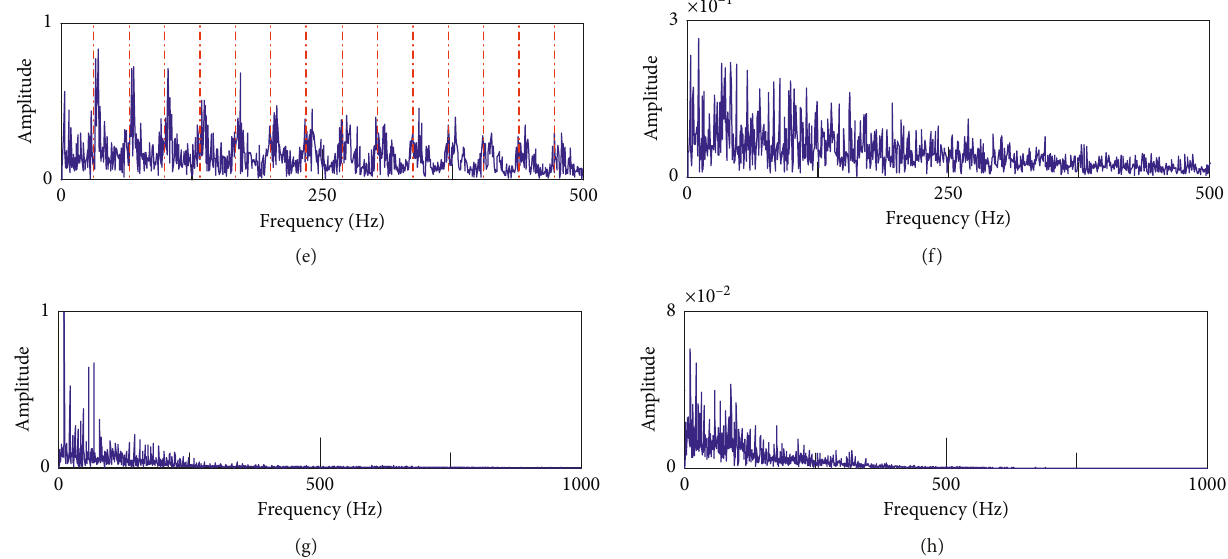
Figure 23: Results obtained by EEMD: (a–d) IMFs; (e–h) squared envelope spectra (red dash-dotted lines: f